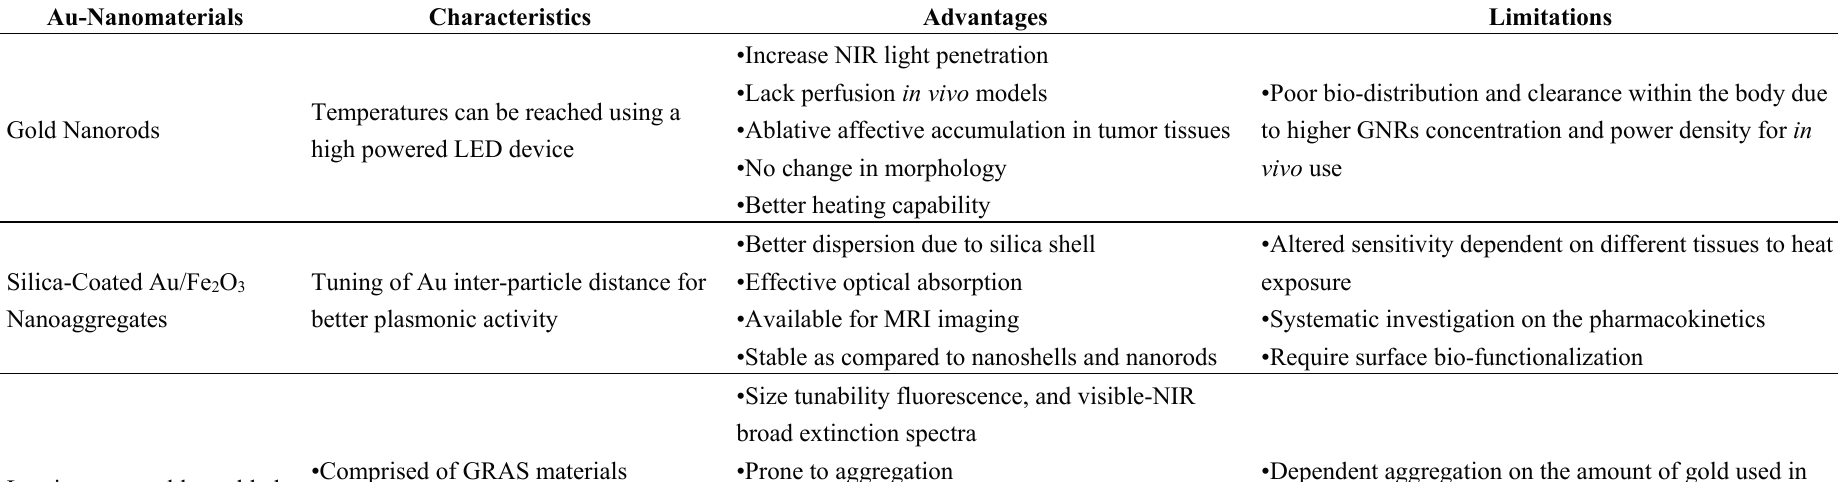
Table 1. Characteristics, advantages and limitations of